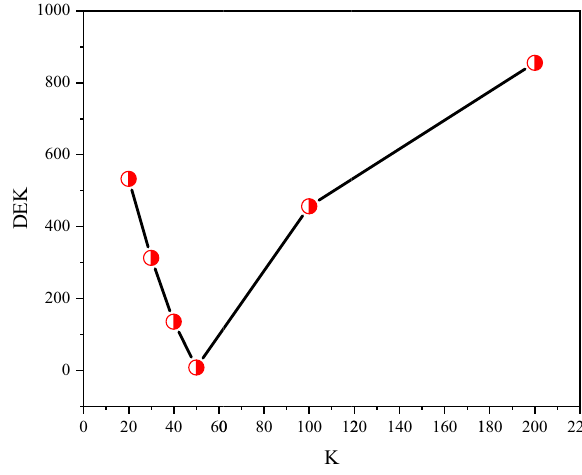
Figure 16: Relation of K in the predicted model and DEK value.